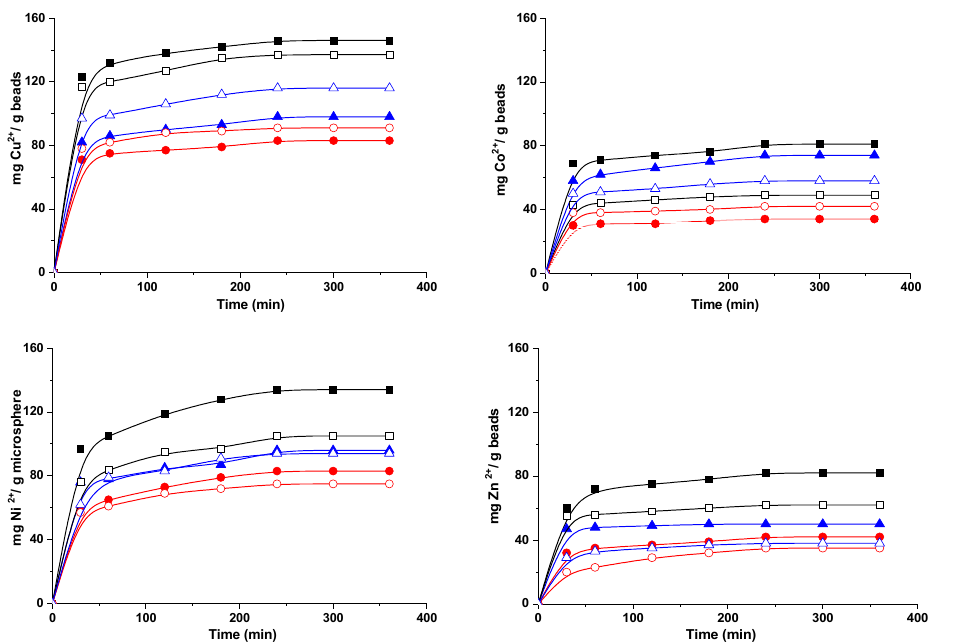
Figure 8. Sorption of Cu 2+ , Co 2+ , Ni 2+ and Zn 2+ onto composite beads based on PS (square), WS (circle) and RS (triangle) and using hydrogel beads CS/SgAx (close symbols) or CS/SgAN-Ax (open symbols).